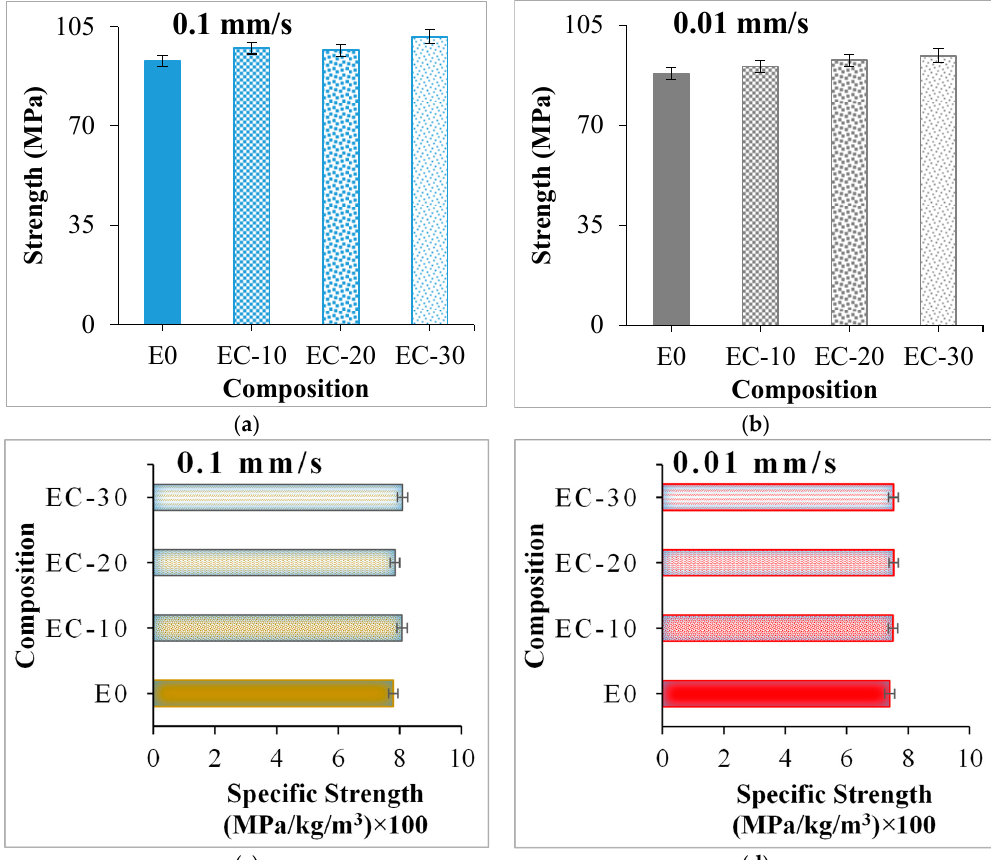
Figure 7. Experimentally measured flexural strength at ( a ) 0.1 mm/s and ( b ) 0.01 mm/s, and specific flexural strength at ( c ) 0.1 mm/s and ( d ) 0.01 mm/s.